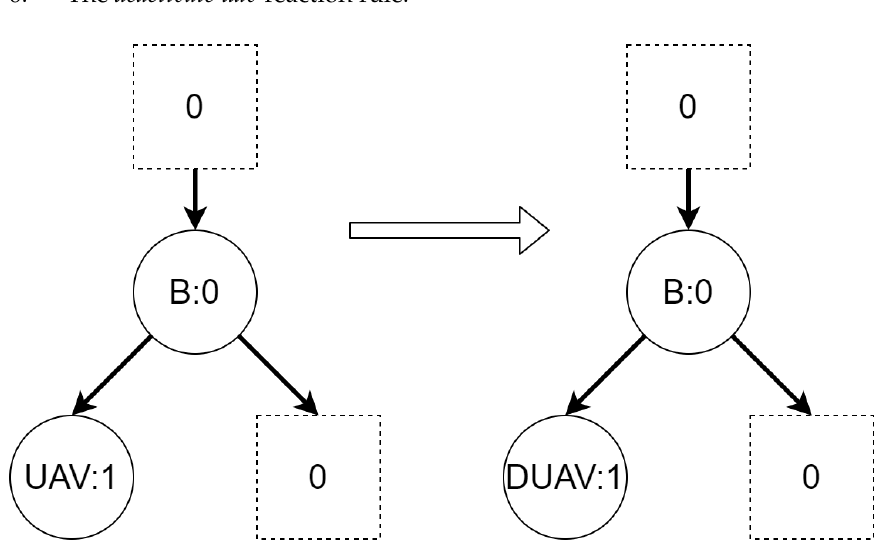
Figure 13. Reaction rule deactivate uav for scenario 2.